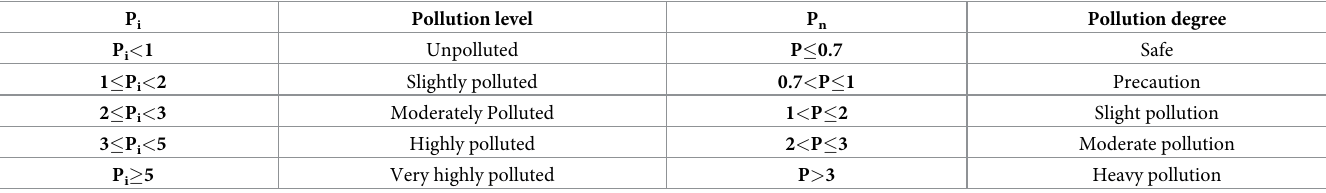
Table 1. Classification of pollution levels for Pi and